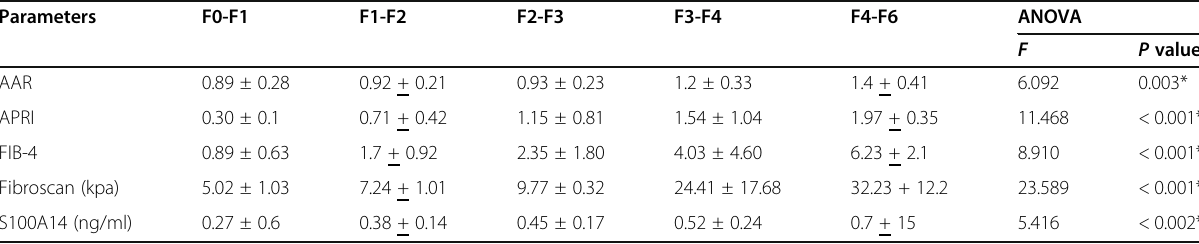
Table 5 Comparison between non-invasive markers at fibrosis stages Parameters